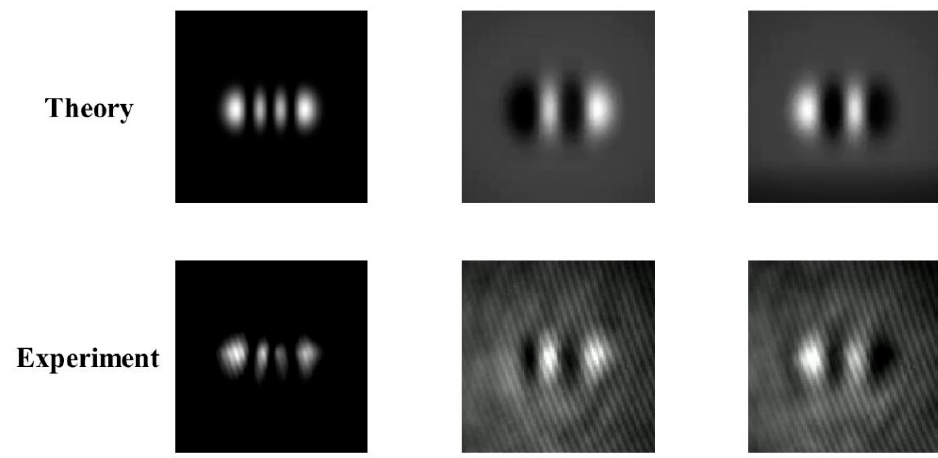
Figure 4. Theoretical and experimental results of the HG30 mode interferogram.